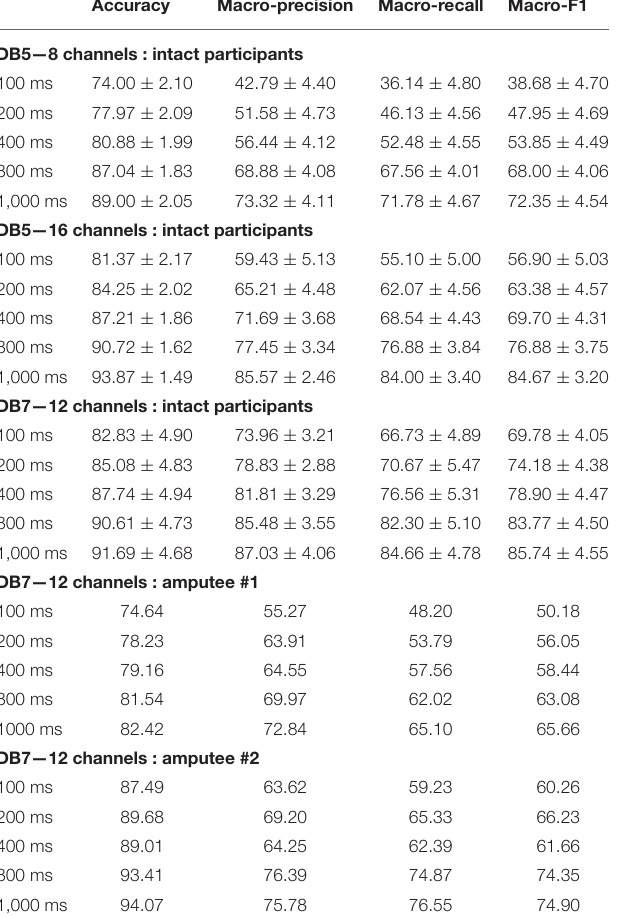
TABLE 3 | Accuracy and macro-averaged metrics of the proposed deep neural network classifiers for 41 hand movements. Accuracy Macro-precision Macro-recall Macro-F1